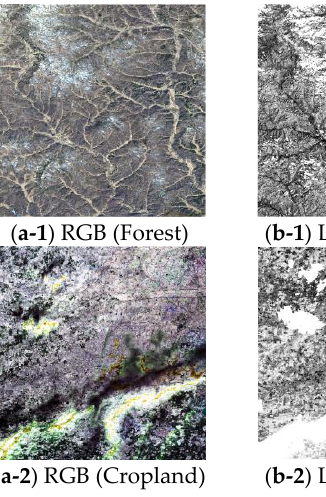
Figure 7. The verification of this paper’s NDVI and Sentinel NDVI from a visual point of view.